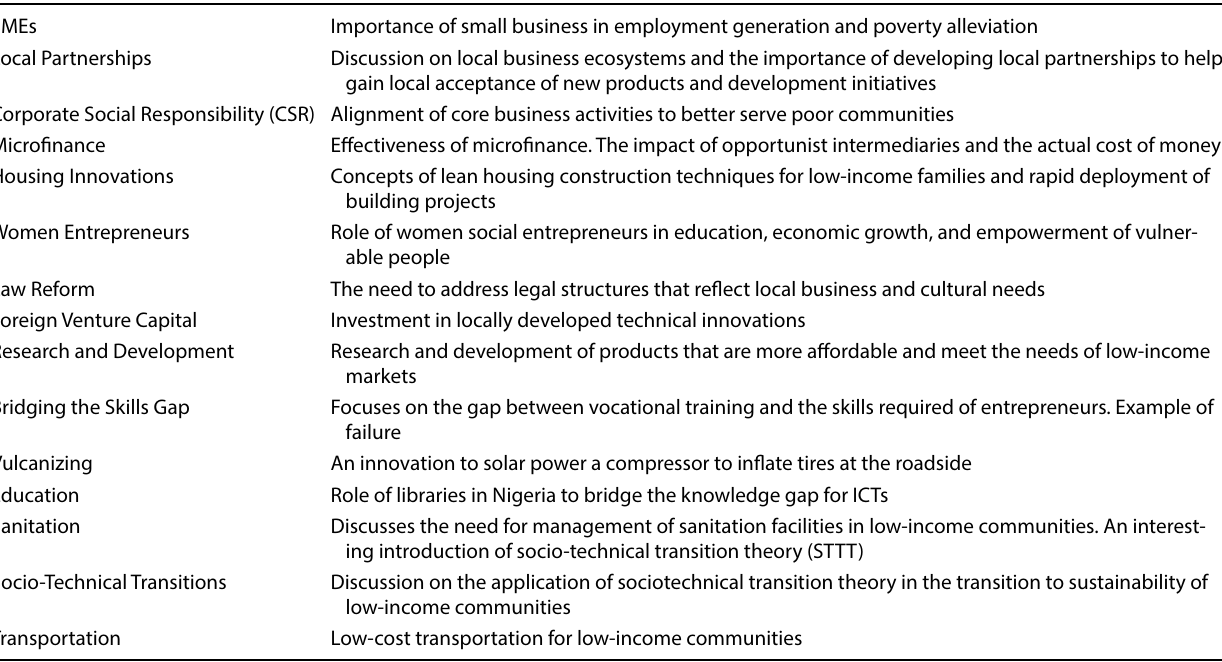
Table 4 Summary of Research Themes